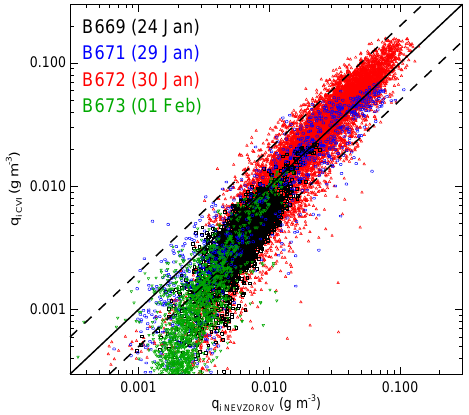
Figure 7. A comparison of 1Hz Nevzorov data and CVI q i mea- surements in midlatitude cirrus clouds. The solid line is the 1 : 1 line, and the dashed lines represent a factor-of-2 difference between the